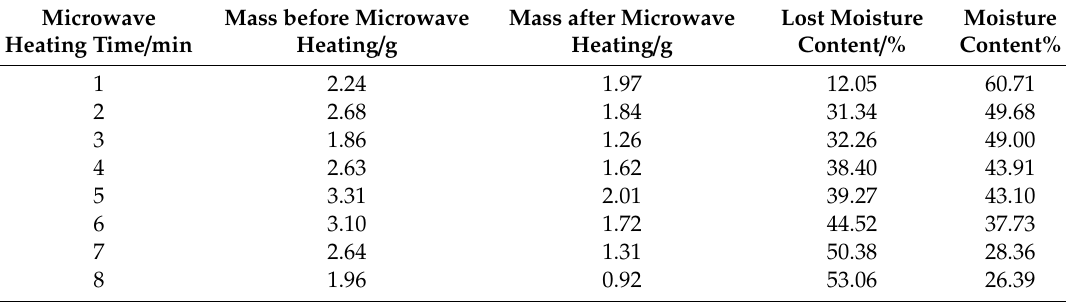
Table 2. E ff ect of microwave oven heating on rice leaves on moisture